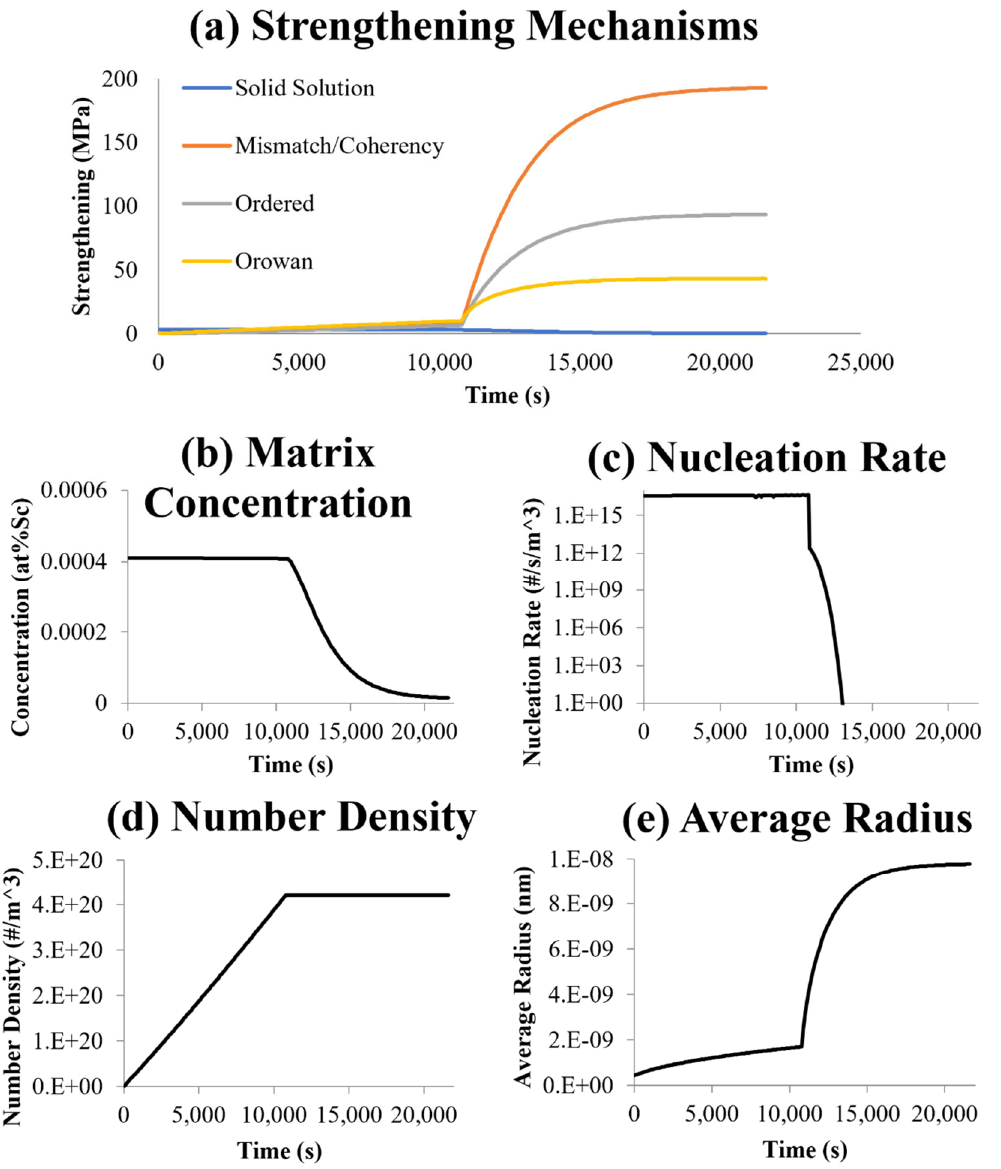
Figure 7. Graphs representing simulation outputs for Sample 2A (described in Table 2 and Figure 5). Throughout the simulated heat treatment, these outputs show ( a ) the predicted strengthening effect if various strengthening mechanisms are dominant, ( b ) the concentration of Sc atoms in solution in the matrix, ( c ) the simultaneous nucleation rate of new precipitates, ( d ) the number density of existing precipitates in the sample, and ( e ) the average radius of all existing precipitates. It should also be noted that the average radius reached in sample 2A clearly exceeded the optimal target of 1–3 nm for order strengthening, resulting in the unfortunate domi ‐ nance of the Orowan strengthening mechanism. This was the case in all the initial simu ‐ lations (1A–4B). Throughout these tests, the difference in strengthening effect between the predicted Orowan and ordered mechanisms was consistently lower at the conclusion of the Al ‐ 0.07Sc at% simulations than in the Al ‐ 0.04Sc at% (~10 MPa versus ~50 MPa). This phenomenon can be linked directly to the fact that the average precipitate radius pre ‐ dicted for the Al ‐ 0.04Sc at% was consistently higher than for the Al ‐ 0.07Sc at%, which can in turn be linked to the consistently smaller precipitate number density at the end of t 1 within these simulations. Therefore, heat ‐ treatment adjustments aiming to increase pre ‐ cipitate number density should increase the strength. The precipitate sizes in the Al ‐ 0.04Sc